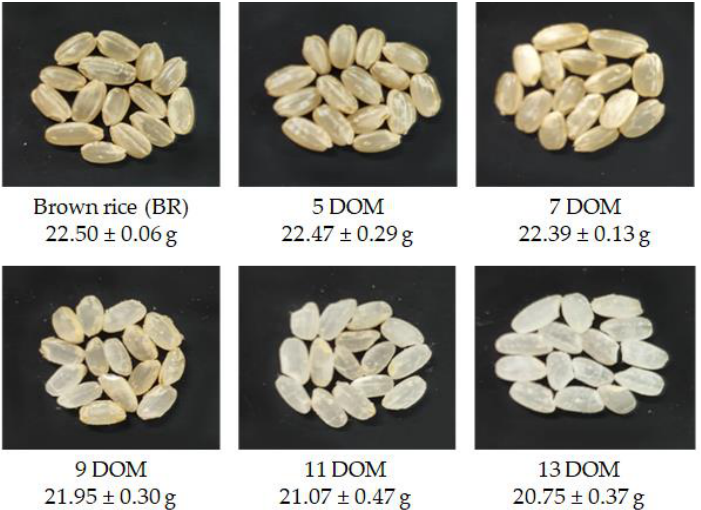
Figure 1. Representative photos and the 1000-grain weight (g, mean ± SD) of rice, according to degree of milling (DOM) (brown rice (BR) to 13 DOM). The 1000-grain weight is a factor of the weight of grains and the number of grains (1000), which is one of the important agronomic traits. Here, the 1000-grain weight shows clearly how much the rice grain weight varied depending on rice milling degree.